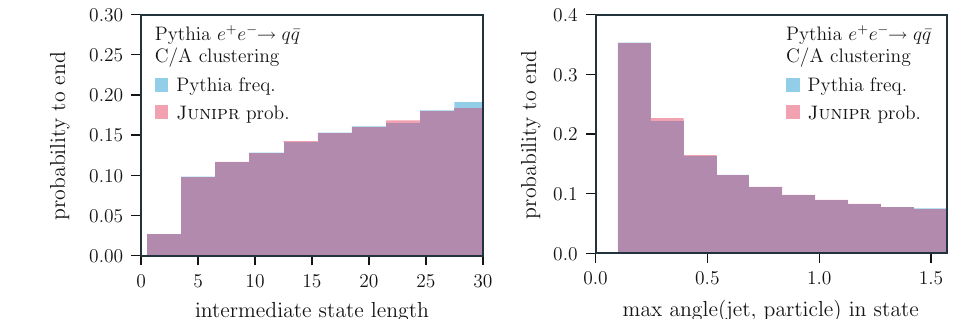
Fig. 7 Validationof P end ,theprobabilitythatthetreeshouldend.Com- parisonismadebetweenactualoutcomesinthevalidationsetof Pythia jets and Junipr ’s probabilistic predictions for these jets. (Left) P end as